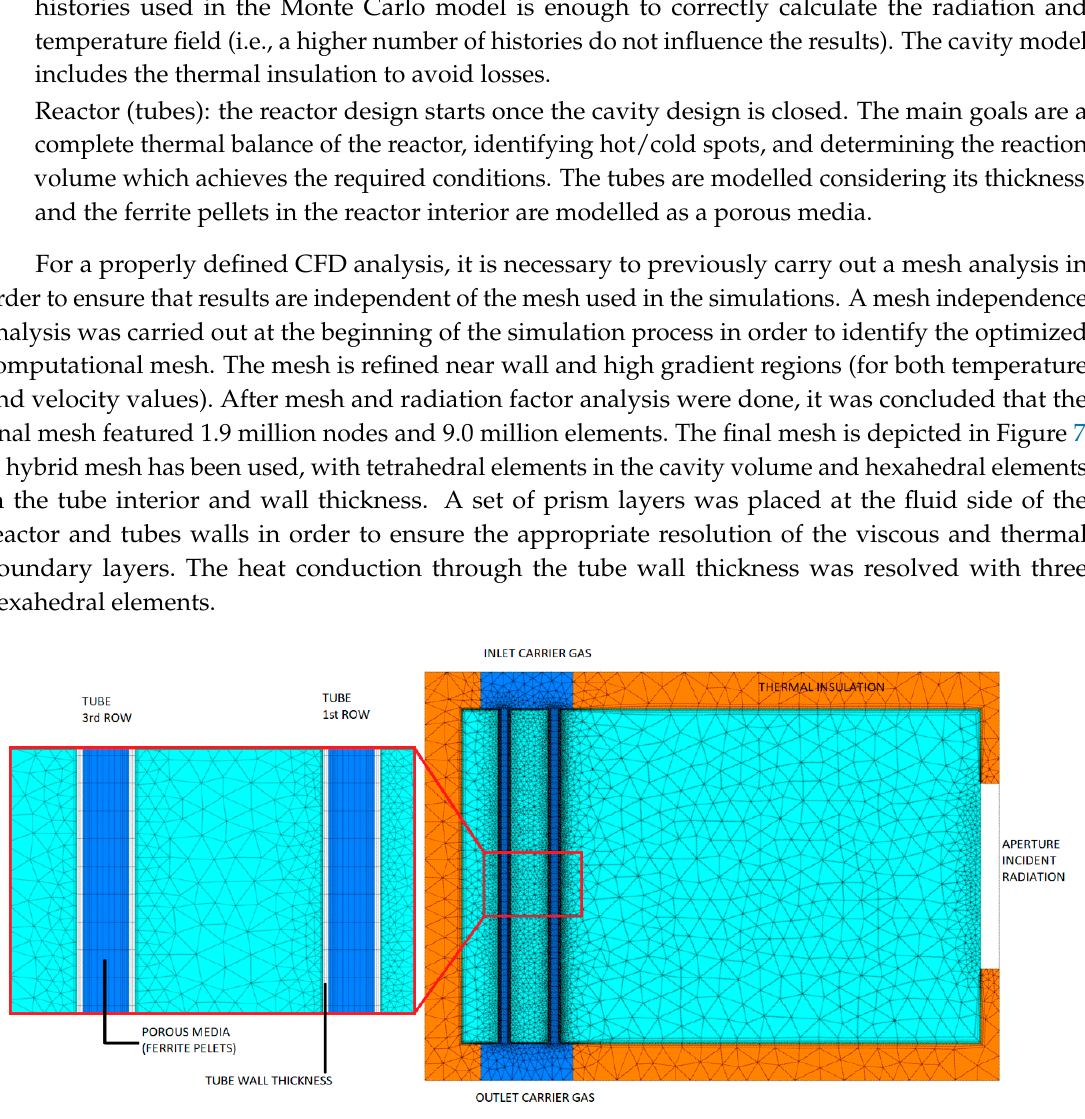
Figure 7. CFD mesh used for the solar reactor simulation (tubes detail shown on the left).